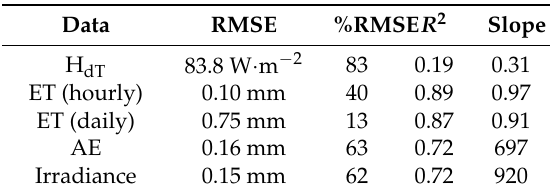
Figure 3. Crop height for 2015 ( a ) and 2016 ( b ), LAI for 2015 ( c ) and 2016 ( d ), and daily lysimeter ET for the 2015 ( e ) and 2016 ( f ) study periods. Table 1. Regression statistics from comparison of hourly and daily H and ET data between SLS and lysimeter.